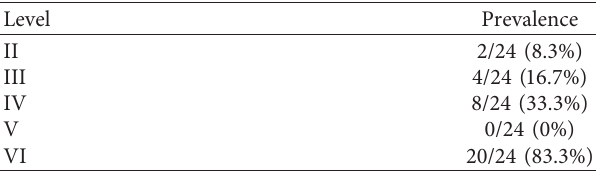
Table 2: Neck LN metastasis